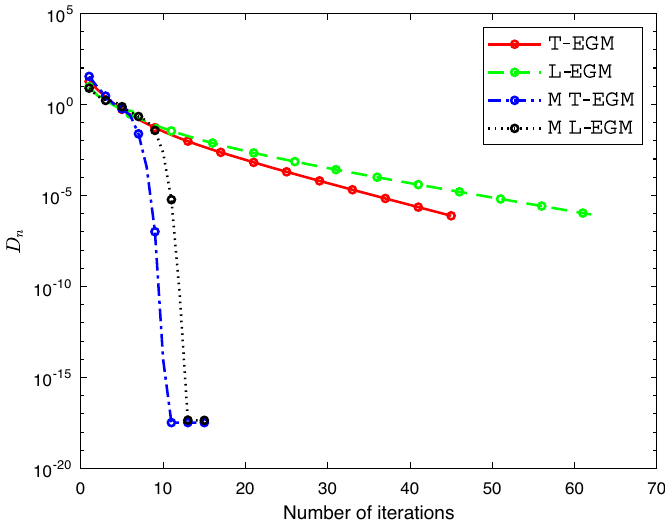
Figure 3: Numerical illustration of Algorithms 1 and 2 with Algorithm 1 in [ 28 ] and Algorithm 1 in [ 29 ] while N 100.